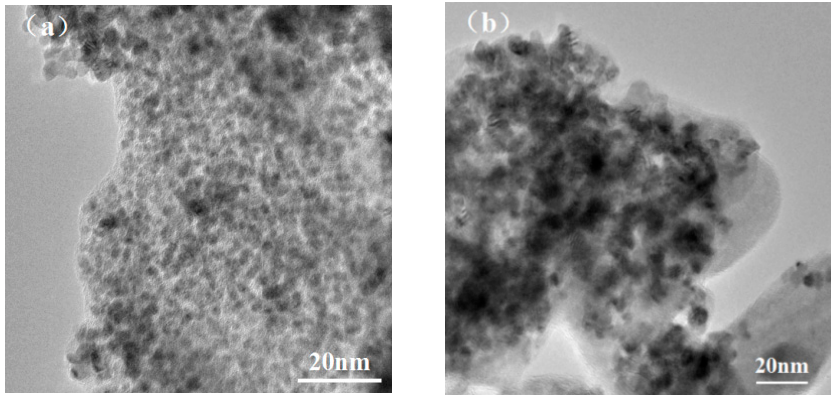
Figure 15. TEM images of the Pd / γ -MnO 2 catalyst before ( a ) and after ( b ) stability